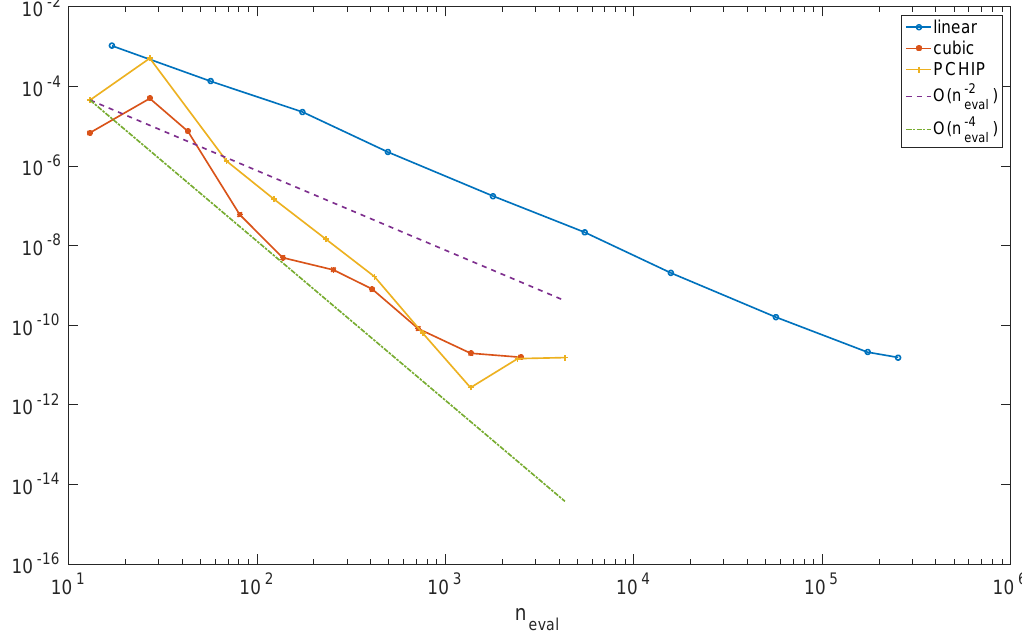
Fig. 4 In continuous line, the graphics of | E − ˆ E 15 | as a function of n eval for ε k = ε varying from 10 − 1 to 10 − 10 , applied to each local rule and f 1 . For comparison, in discontinuous line are shown the growth rates O ( n − 2